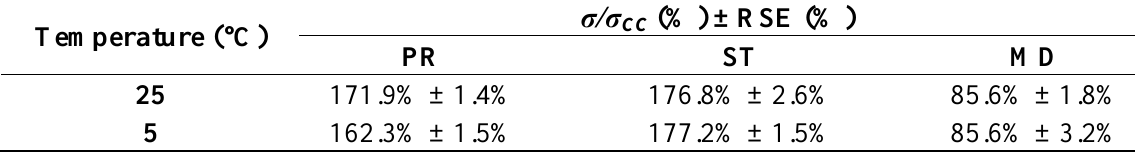
Table 1. Average σ / σ and relative standard errors (RSE) at 1000 Hz 25 and 5 °C of CC NaHCO solutions aged for 310 days in 2 mL volume of 2.5 mL flasks under conditions 3 PR—exposed to daylight, ST—protected from daylight and MD—at −20 °C; treatments are